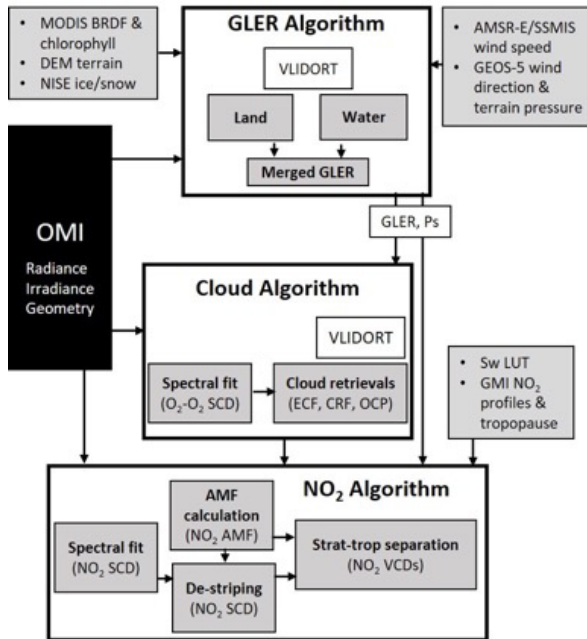
Figure 1. Schematic diagram of the NASA OMI NO 2 algorithm version 4.0, which is coupled with the cloud- and geometry- dependent surface Lambertian equivalent reflectivity (GLER) al- gorithms that ultimately produce stratospheric (strat) and tropo- spheric (trop) NO 2 vertical column densities (VCDs). Acronyms used here are described in the relevant sections below. VLIDORT: vector linearized discrete ordinate radiative transfer; MODIS: Mod- erate Resolution Imaging Spectroradiometer; BRDF: bidirectional reflectance distribution function; DEM: digital elevation model; NISE: near-real-time ice and snow extent; AMSR-E: Advanced Mi- crowave Scanning Radiometer for Earth Observing System (EOS); SSMIS: Special Sensor Microwave Imager–Sounder; GEOS-5: Goddard Earth Observing System version 5; Ps: surface (terrain) pressure over OMI pixel; ECF: effective cloud fraction; CRF: cloud radiance fraction; OCP: optical centroid pressure; Sw: scattering weight; LUT: lookup table; GMI: Global Modeling Initiative; AMF: air mass factor; SCD: slant column